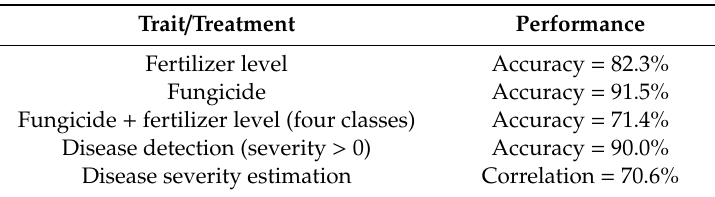
Table 2. Performance values for di ff erent SVM and SVR models predicting the treatments of the wheat field experiment based on UAV